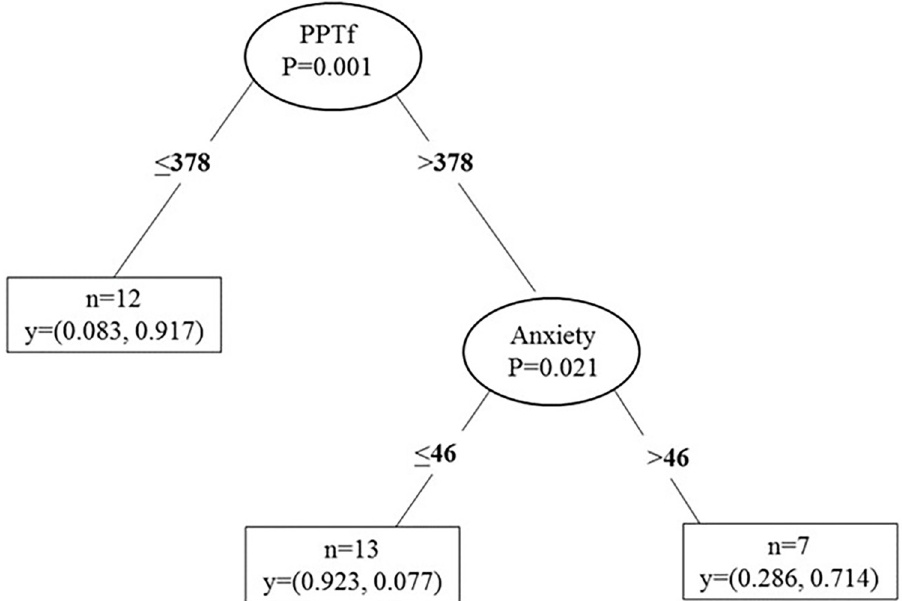
Fig 4. The tree decision analysis to predict DOMS responders. Decision tree analysis set up to predict DOMS responders (VAS � 3) by PPTf (pressure pain threshold in the forearm), below or above 378kPA, and anxiety score below or above 46. The numbers in the circles reflect the level of statistical significance (P); numbers in the rectangular boxes reflect the total number of cases for that outcome (n) and the probability (y) to become a non-responder (first number) or DOMS–responder (second